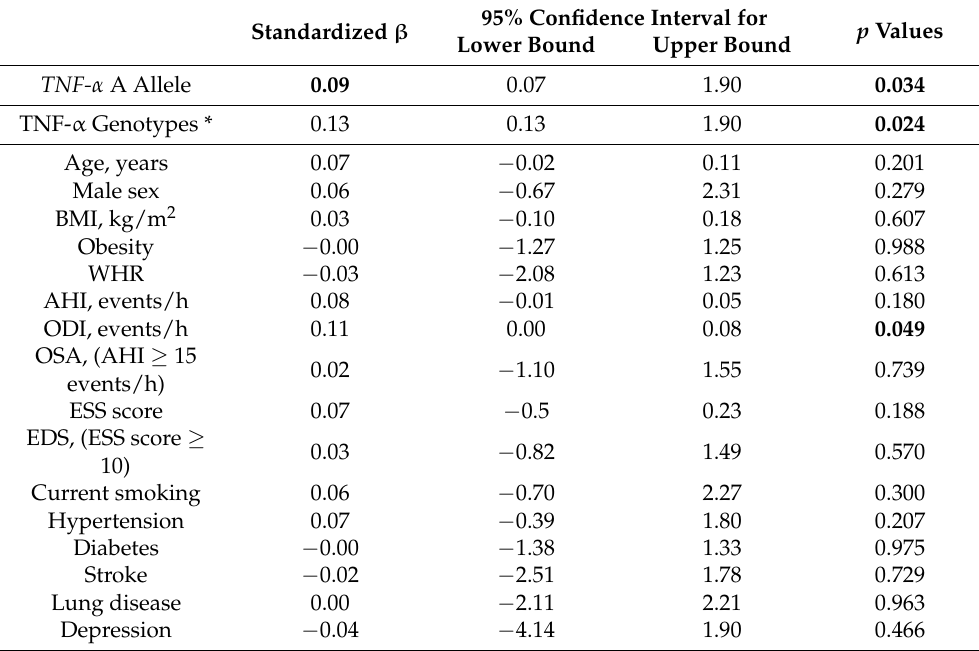
Table 3. Univariate analyses of the variables associated with circulating TNF- α